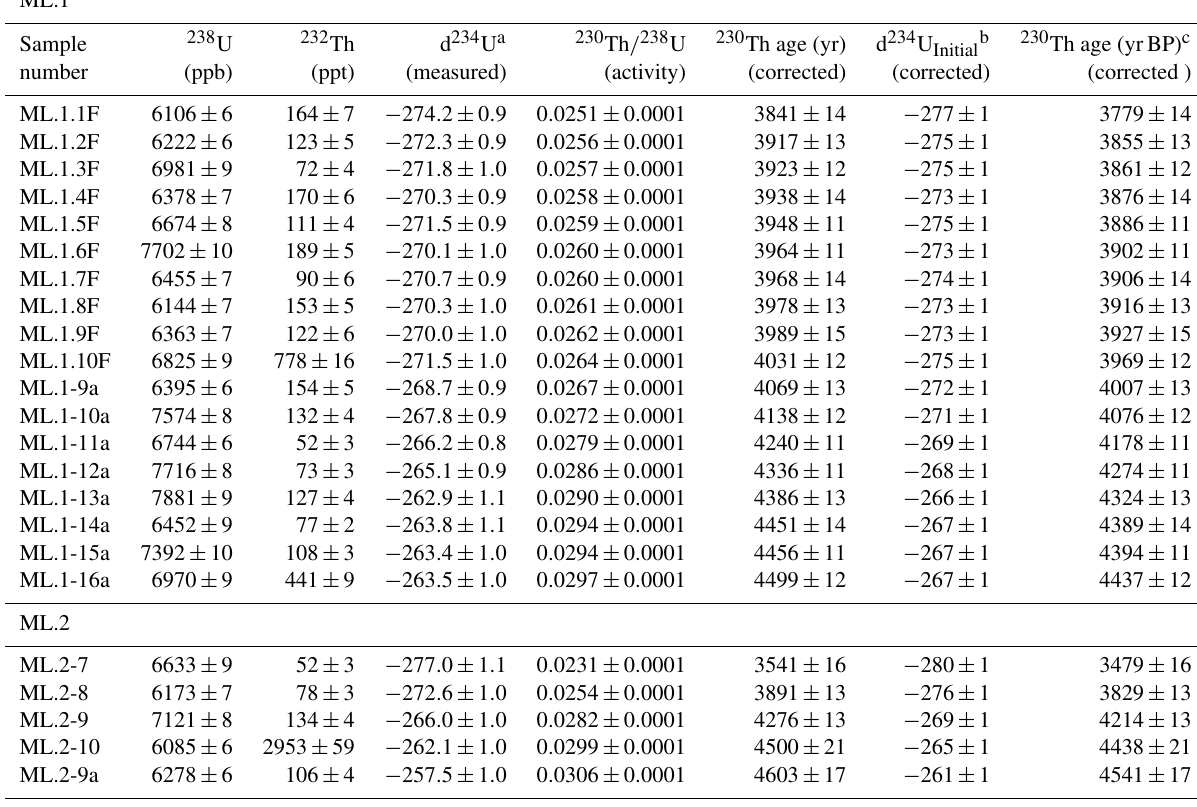
Table 1. 230 Th dating results with the 2 σ analytical